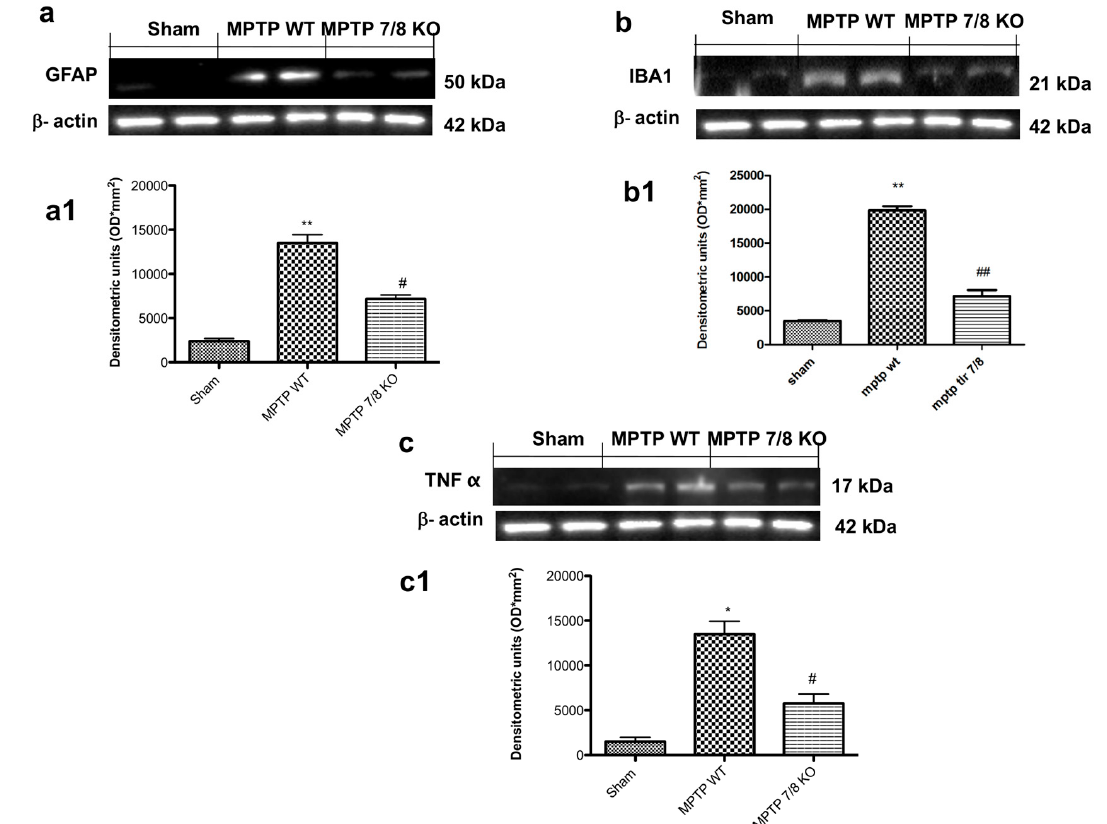
Figure 9. Role of TLR7 / 8 on GFAP, IBA1, and TNF- α expression after MPTP administration. Western blot analysis showed significant expression levels of GFAP and IBA1 in SN of WT MPTP-treated mice, which were reduced in MPTP TLR7 / 8 KO group ( a , a1 , b , b1 , respectively). Western blot analysis also showed an upregulation of TNF- α expression in WT MPTP -treated mice compared to SHAM ( c , c1 ). This expression was notably reduced in TLR7 / 8 KO MPTP- treated mice ( c , c1 ). Each data are expressed as Mean ± SEM from N = 10 Mice for each group. * p < 0.05 vs. SHAM WT; ** p < 0.01 vs. SHAM WT; # p < 0.05 vs. MPTP WT; ## p < 0.01 vs. MPTP